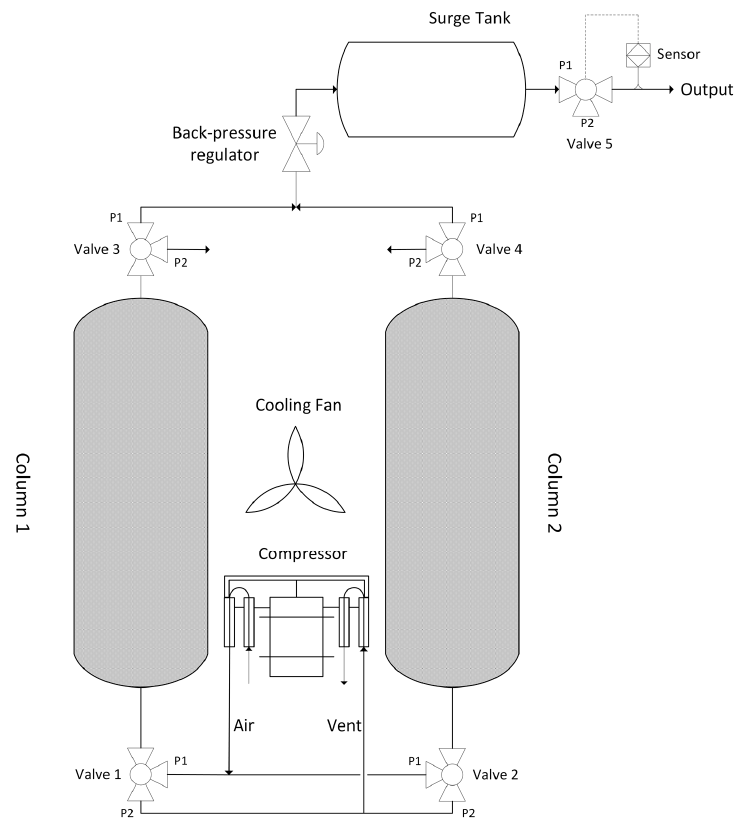
Figure 1. Schematics of the PSA oxygen concentrator.